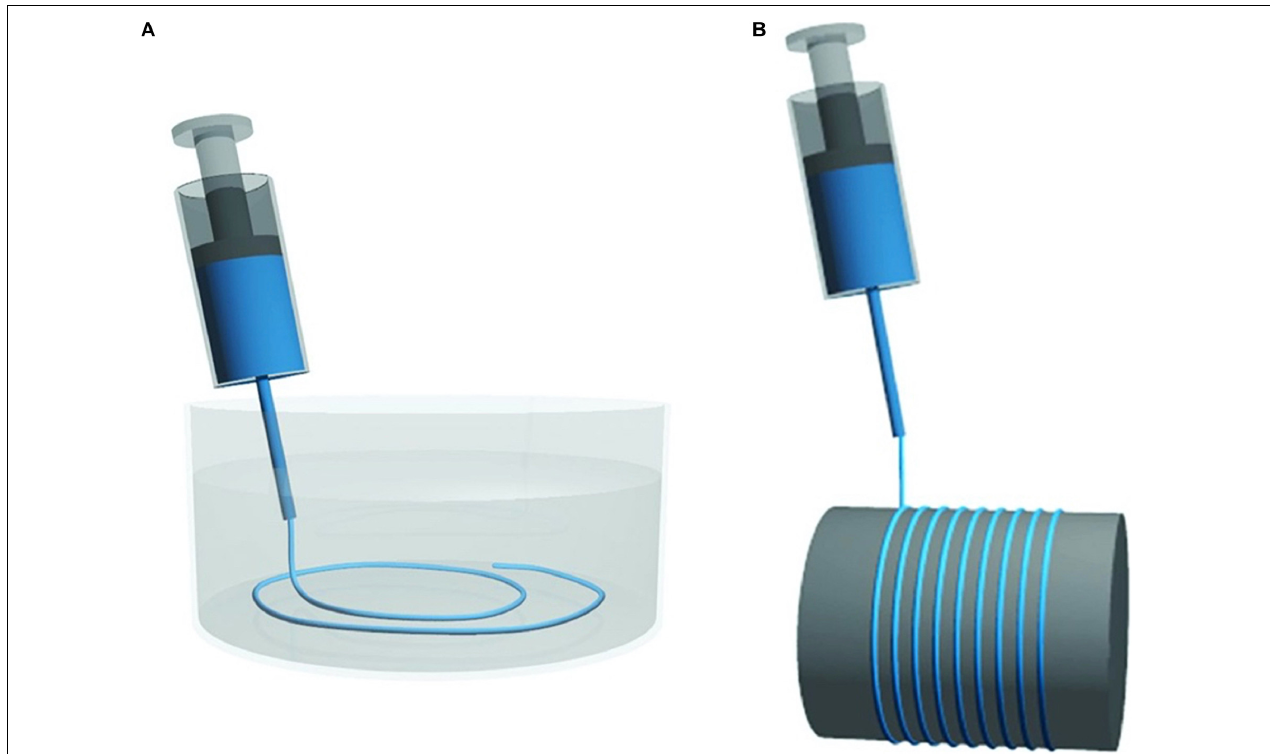
FIGURE 10 | Schematic illustrations of simplified systems for (A) wet-spinning and (B) dry-spinning. Reprinted (adapted) with permission from Lundahl (2018). Copyright (2018) American Chemical Society.